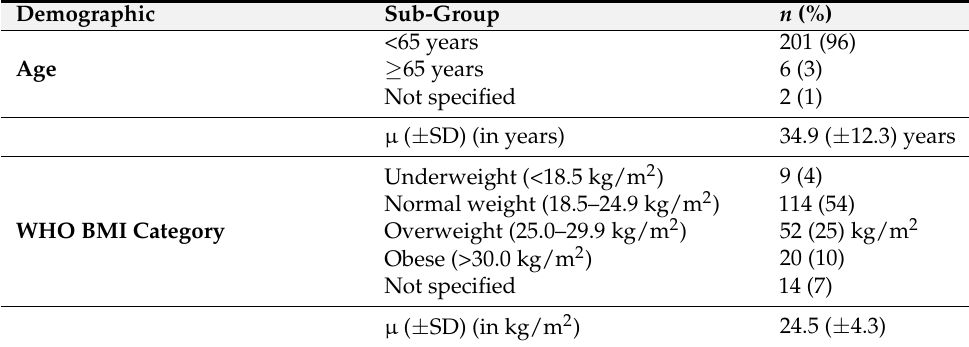
Table 1. Demographic characteristics of